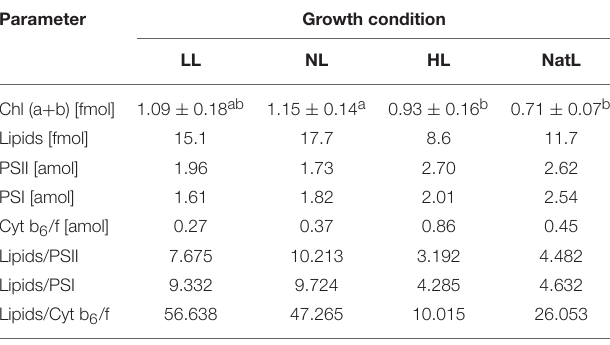
TABLE 5 | Amount of Chl, lipids and protein complexes per chloroplast. Parameter Growth